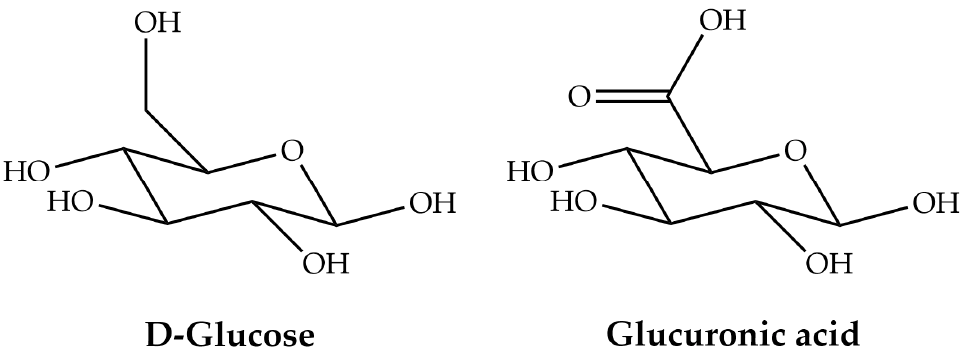
Figure 3. Chemical structures of D-glucose and glucuronic acid.